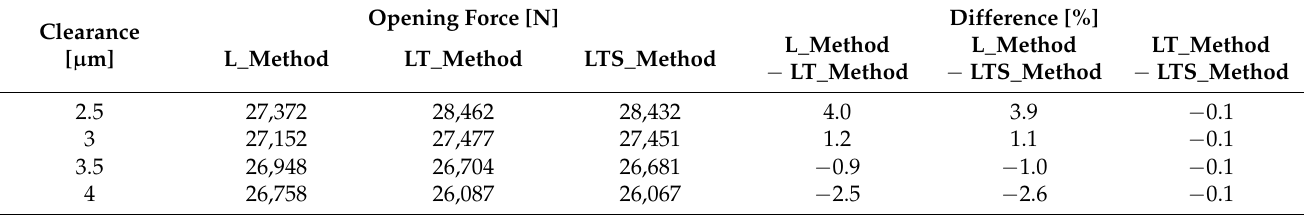
Table 5. Opening force according to clearance at an outer pressure of 60